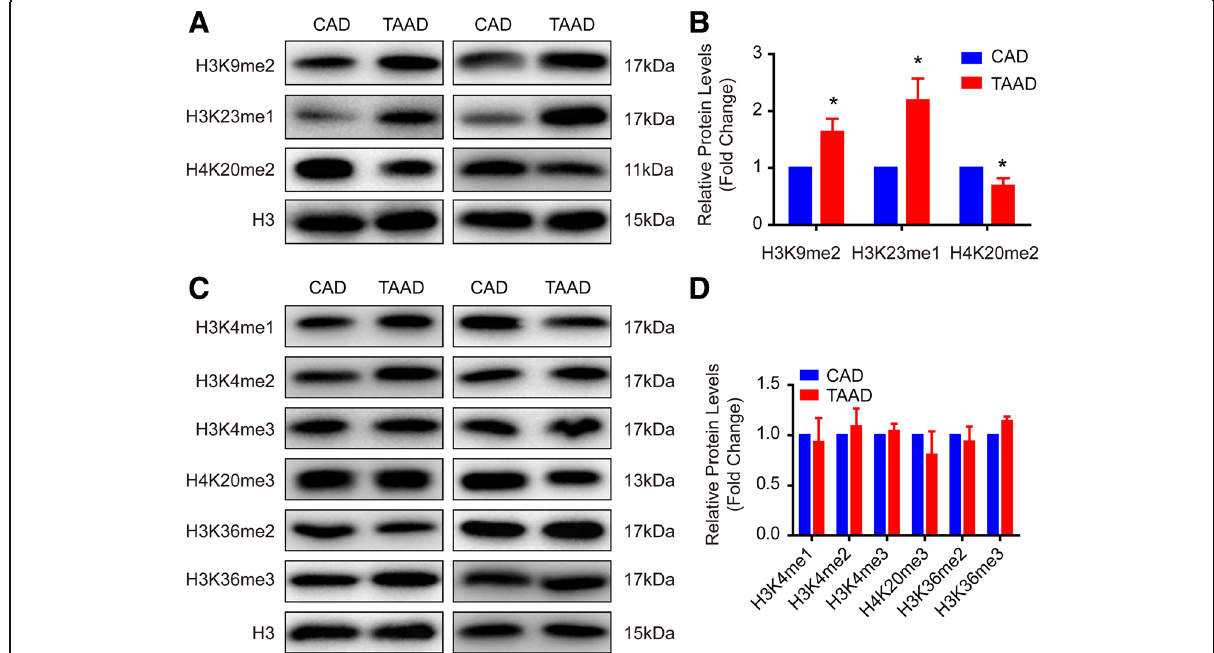
Fig. 3 Histone methylation in samples of human aortic wall. a - d The protein levels of histone methylation were verified by western blotting in the aorta samples of CAD and TAAD patients, ( a and b ) differentially expressed histone methylation in TAAD patients; ( c - d ) comparable histone methylation in two groups. n = 6 pooled samples per group, * p < 0.05 vs. CAD